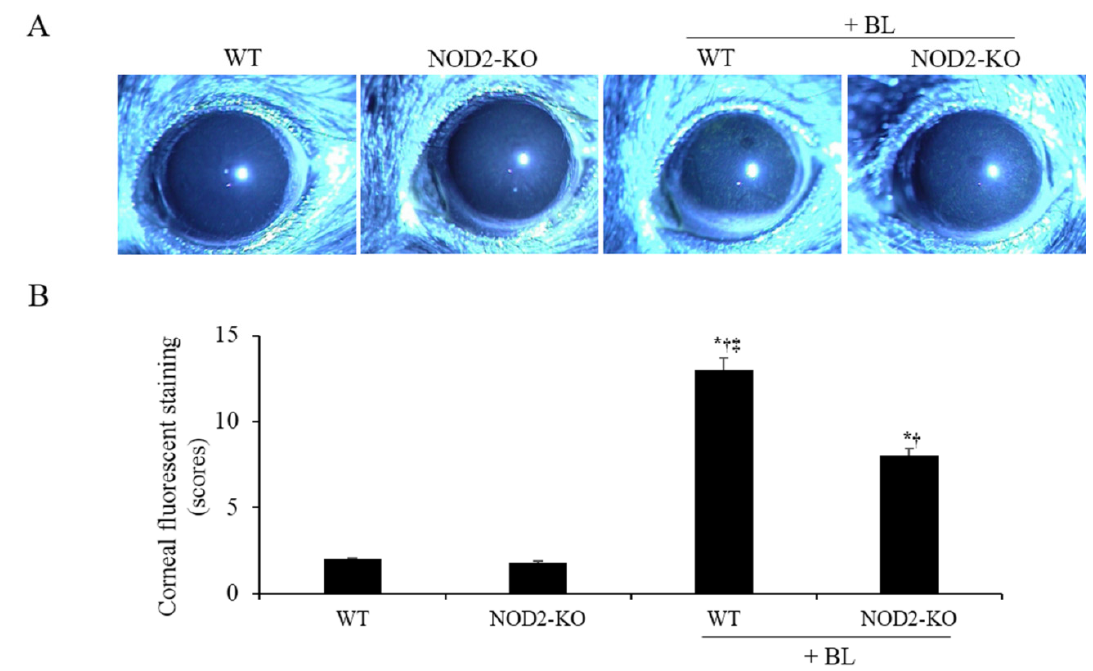
Figure 5. Representative photograph ( A ) and the mean corneal fluorescein staining scores ( B ) in the WT, NOD2-KO, WT+BL, and NOD2-KO+BL groups after 10 days of blue light exposure. * p < 0.05 vs. WT; † p < 0.05 vs. NOD2-KO; ‡ p < 0.05 vs. WT + BL WT, wild type; BL, blue light; NOD2-KO, nucleotide-binding oligomerization domain 2 knock-out.